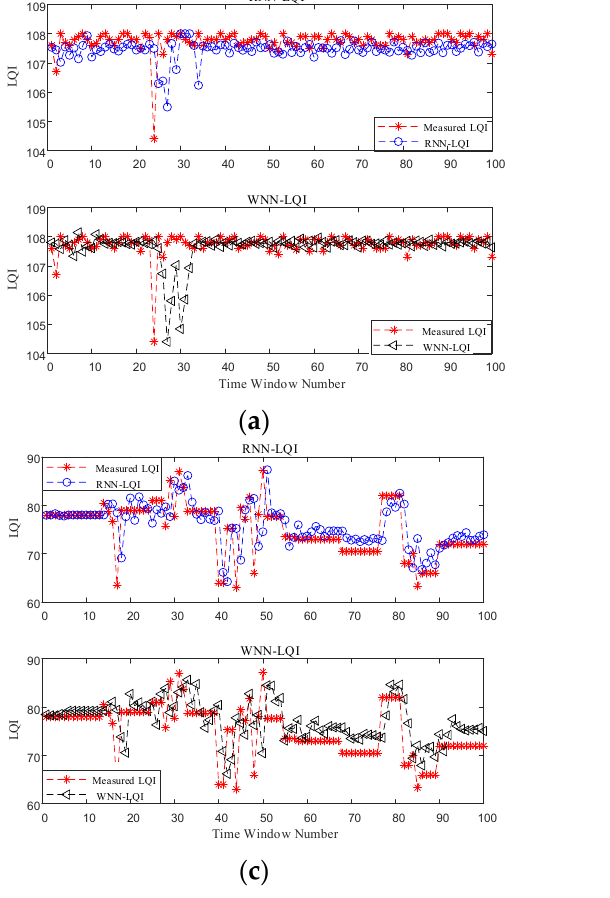
Figure 6. Predicted LQI vs. measured LQI. ( a ) good links, ( b ) moderate links, ( c ) bad links, ( d ) sudden changed links. Table 1. RMSEs of LQI prediction under different link qualities.